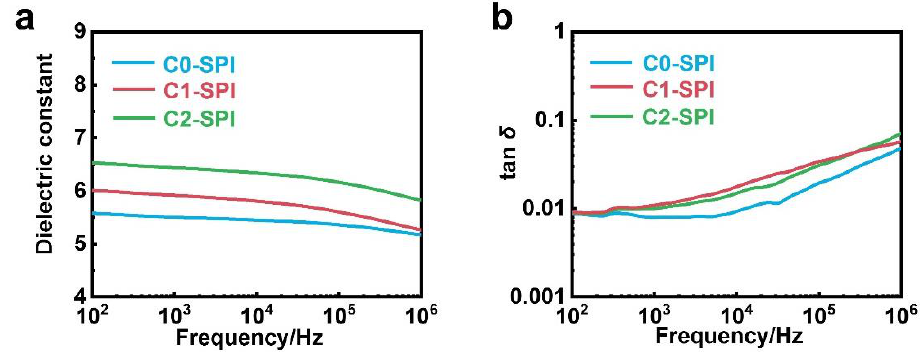
Figure 3. ( a ) Dielectric constant and ( b ) dielectric loss as a function of frequency at room temperature of C0-SPI, C1-SPI, and C2-SPI.